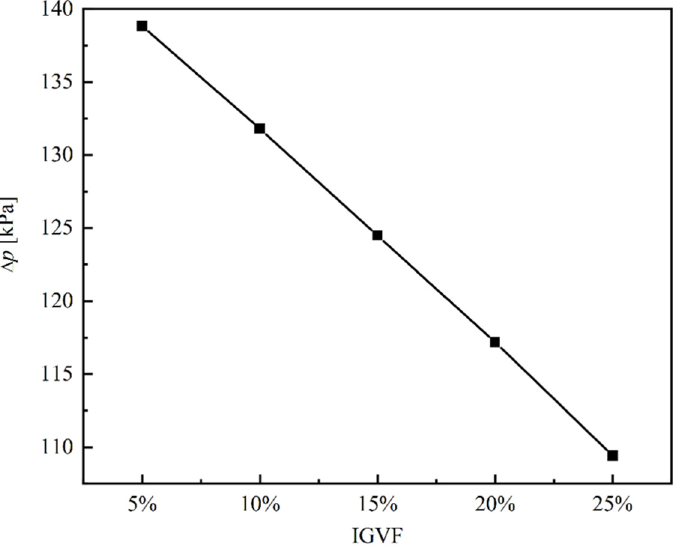
Figure 5. Influence of IGVF on pressure rise of a multiphase pump.